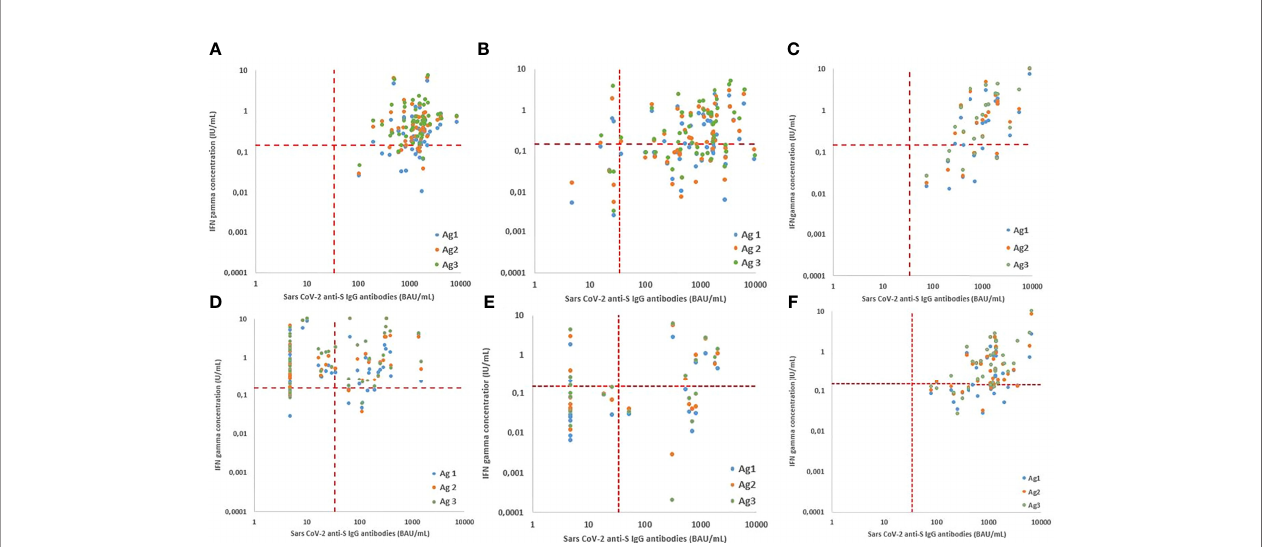
FIGURE 4 | Relationship between cellular and humoral immune response after vaccination with P fi zer BNY162b2 for the healthy control (A) and different patient groups: primary immune de fi ciency patient group (B) PLWH (C) , neurology (D) rheumatology (E) and CKD (F) patient groups at T3. The relationship is presented for antigen 1 (blue), antigen 2 (orange) and antigen 3 (green). Cellular responses were assessed by measuring interferon (IFN) gamma (IU/mL) by the QuantiFERON SARS-CoV-2 test on the Liaison XL analyser and Humoral responses assessed by the Liaison ® SARS-CoV-2 TrimericS IgG chemiluminescent immunoassay on the Liaison XL. Correlation was calculated by using Spearman ’ s correlation coef fi